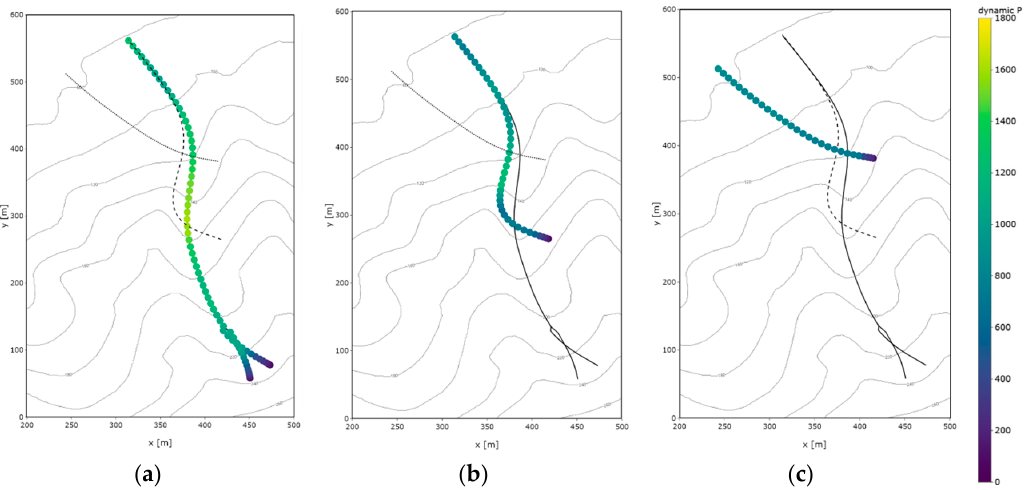
Figure 17. The hazard assessment map generated from the developed framework showing the impact pressure (unit: kPa) of the debris-flow cluster for ( a ) flowpath A, ( b ) flowpath B, and ( c ) flowpath C. The flowpaths are plotted separately for clarity.